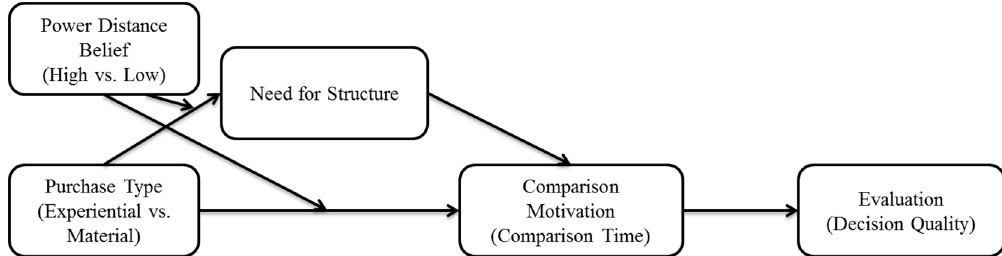
Figure 1. Research model.